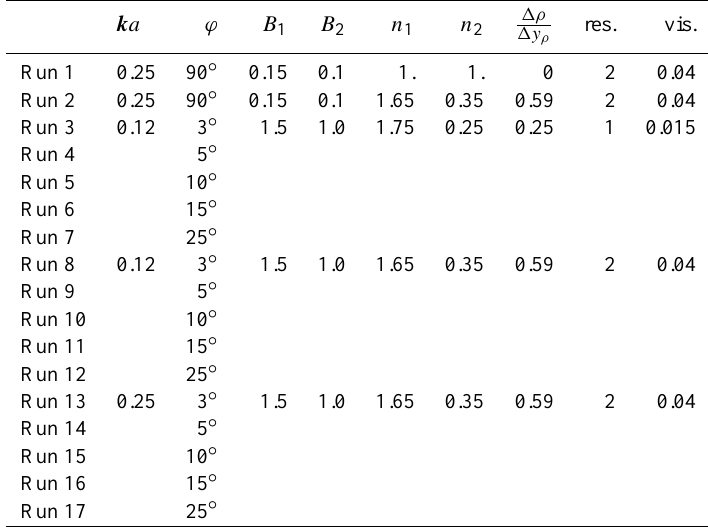
Table 2. Simulation Runs. Empty blocks indicate no change from the line